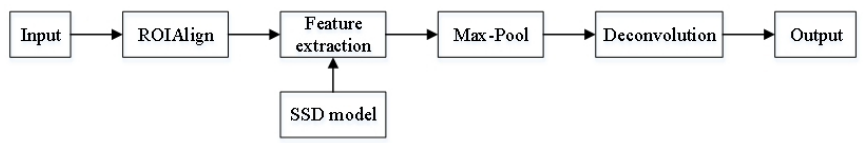
Fig. 2. Proposed model